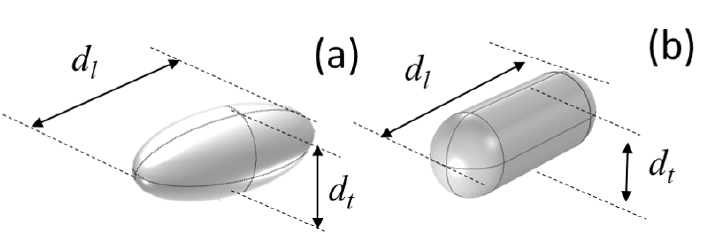
Figure 2. Geometrical models for the nanoparticles using ( a ) a prolate ellipsoid, and ( b ) a cylinder terminated with two hemispherical